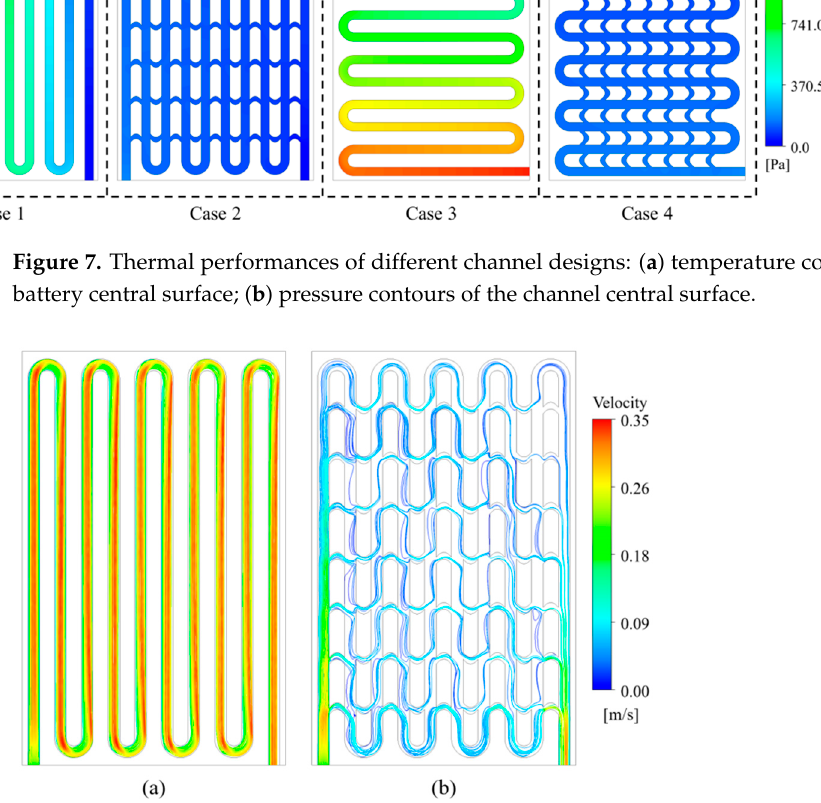
Figure 8. Pathlines for the ( a ) conventional serpentine channel and ( b ) the intersected channel at the inlet velocity of 0.2